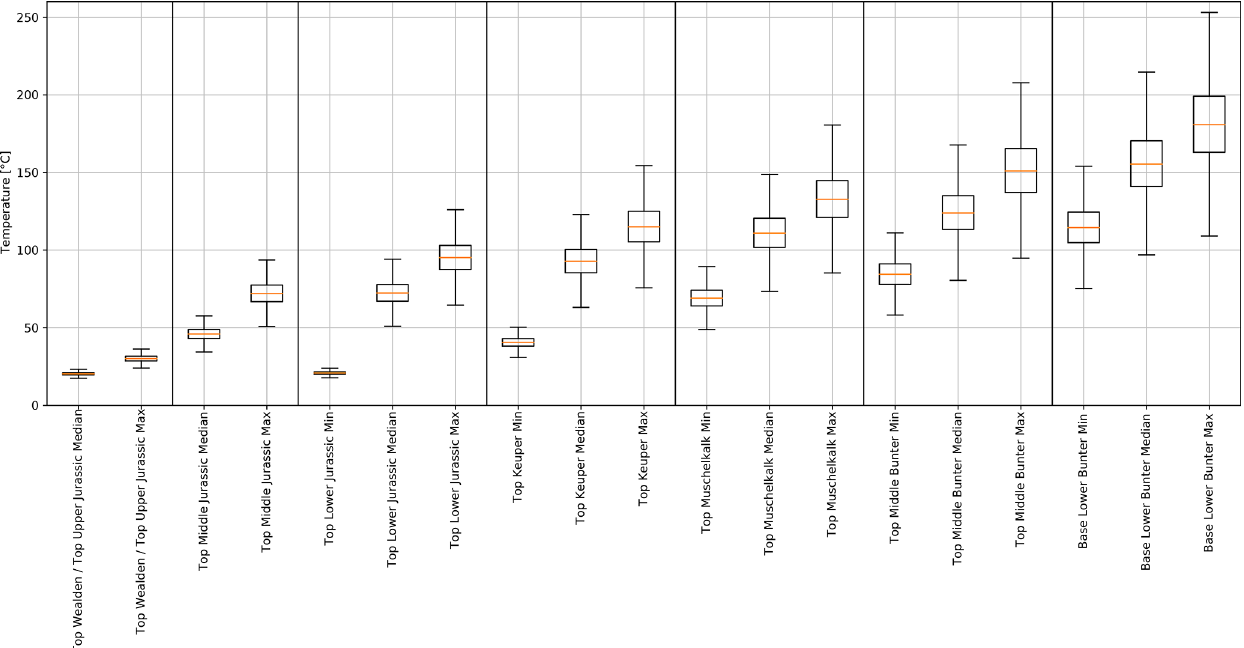
= 34 . 1 ◦ Ckm − 1 (Agemar et al., 2014). d z